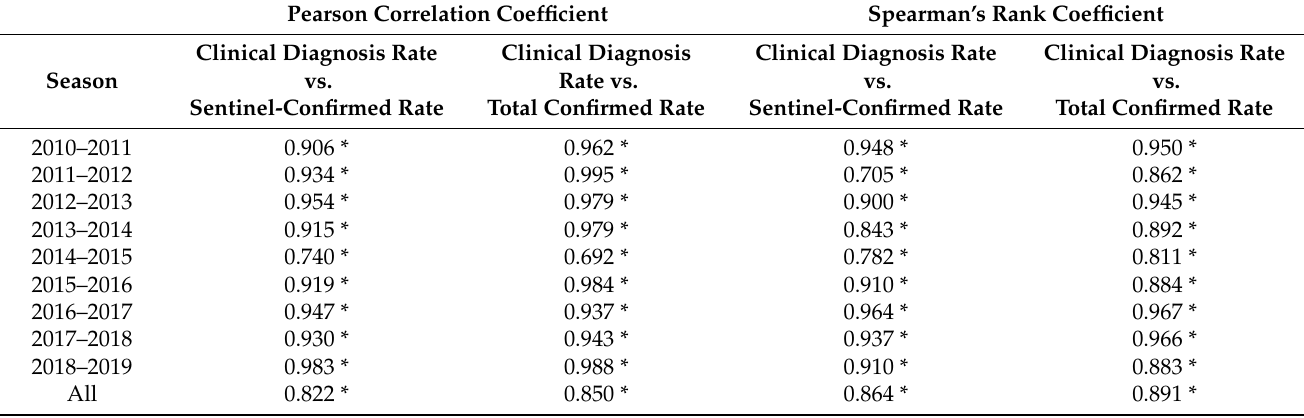
Table 2. Pearson and Spearman correlation coefficients between rates of clinical diagnosis, senti- nel-confirmed, and total confirmed cases.